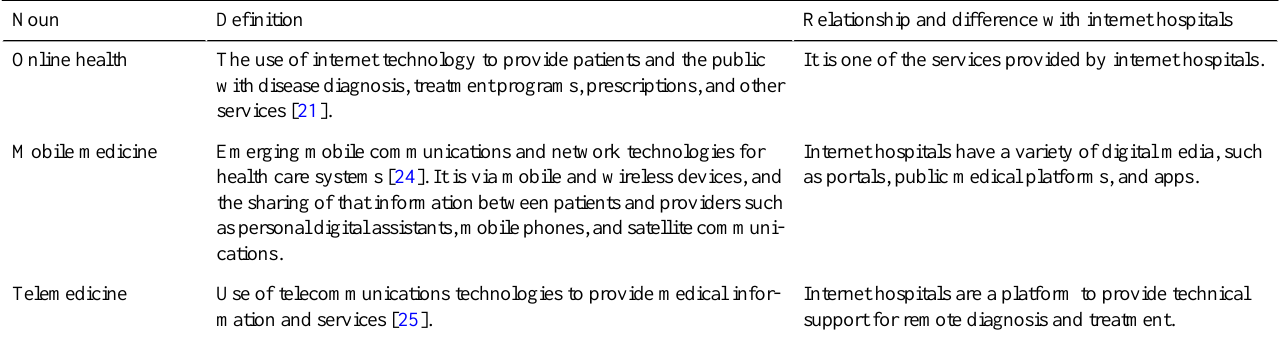
Table 1. The relationship and difference between others with internet